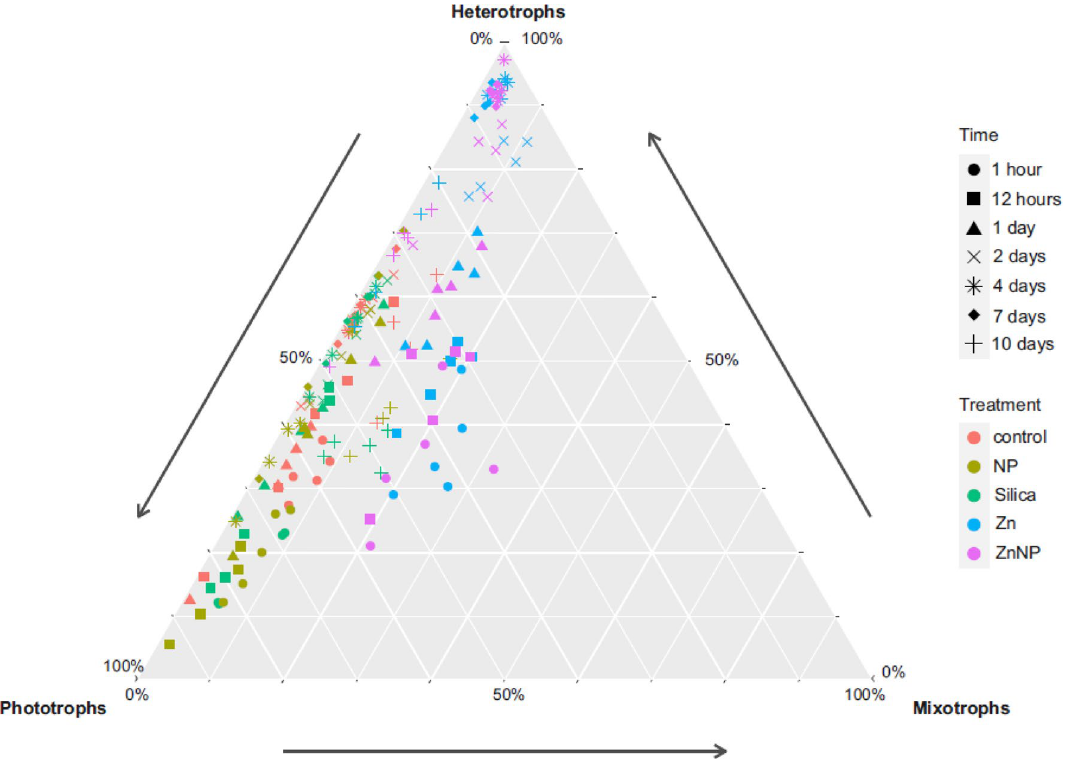
Figure 3. Ternary plot showing the functional community composition and its shift. Treatments are color- coded and sampling points are shape coded. Consumers include parasitic and fungal OTUs. Ternary plots are three dimensional composition plots. Relative abundances of samples always sum up to 100%. The closer a sample is located towards one corner (nutrition type), the more organisms affiliated with this nutritional type are represented in the community in terms of relative abundance. Samples close to each other are similar in their functional community composition. Distances are based on the relative abundance of the three functional groups, thus distances between samples behave